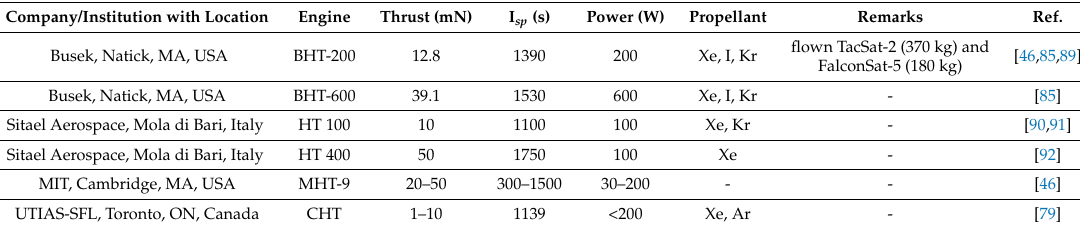
Table 6. Summary of Hall